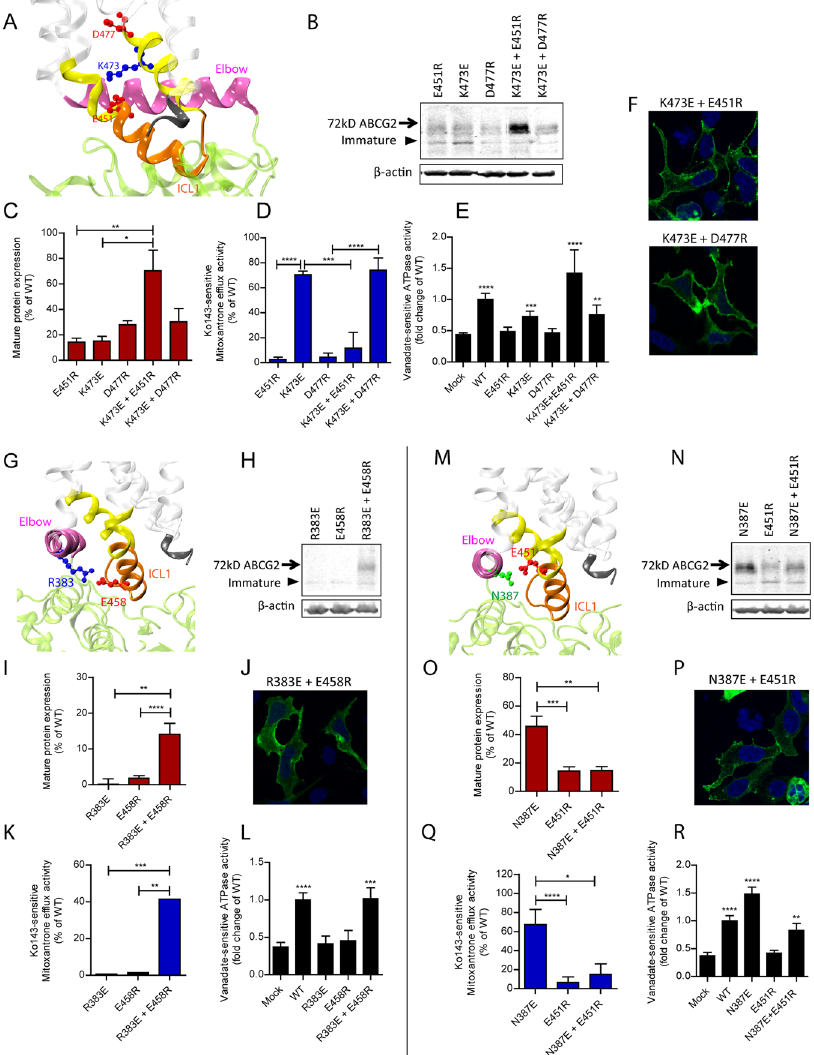
Figure 4. Interactions of charged residues at within transmission interface. Residues in the transmission interface were subjected to mutational changes as indicated followed by their expression in HEK293 cells. ( A , G and M ) Zoom-in views showing the side chains as balls-and-sticks with the positions of negative residues (red), positive residues (blue) and polar residues (green) in the transmission interface; ICL1 (orange); distal helical parts of TMH2 and TMH3 (yellow); TMHs (transparent white); elbow helix (pink); C-terminus (black); NBD ribbon (green). ( B , H and N ) Immunodetection of ABCG2 variants expressed in HEK293 using the anti-ABCG2 (BXP-21) antibody. β -actin was used as an internal loading control. ( C , I and O ) Quantification of normalized ABCG2 variants are from several independent experiments (n = 3). The blots from different gels were divided by the white spaces. ( D , K and Q ) Mitoxantrone efflux activity of ABCG2 variants are shown as percentage relative to WT from several independent experiments (n = 4–7). The bar graphs of expression and mitoxantrone efflux experiments were represented as means with SEM; **** P < 0.0001; *** P < 0.001; ** P < 0.01; * P < 0.1. ( E , L and R ) Vanadate-sensitive ATPase activities of ABCG2 mutants expressed in HEK293 cells. Data are from several independent experiments (n = 7–8) using three batches of membrane preparations. Data are represented as fold change relative to WT. All means include SEM; **** P < 0.0001; *** P < 0.001; ** P < 0.01 vs. empty plasmid transfected HEK293 (mock). ( F , J and P ) Membrane localization of GFP-tagged ABCG2 mutants was detected in the GFP channel (green). Nuclei were stained with DAPI (blue). Microscopy data are from representative duplicate